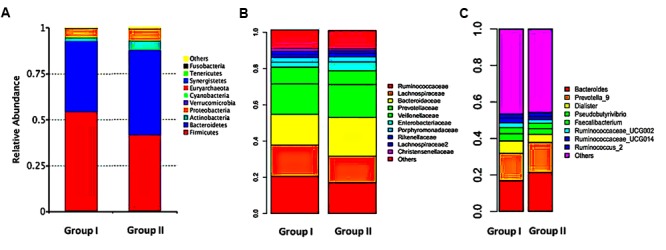
Relative abundance of gut microbiome. Gut microflora were profiled with the mothur pipeline. Phylum (A), family (B), and genus (C) level taxonomy are presented as percentage of total sequences. Different colored bars indicate different gut microbial taxa.